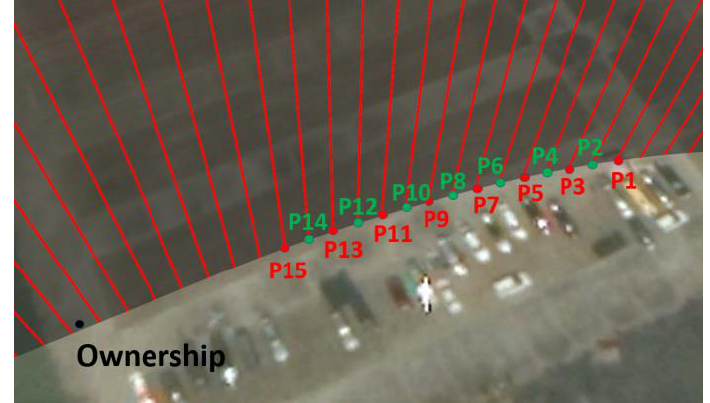
Figure 27. Measurements of GPS data for model evaluation in Experiment 3.